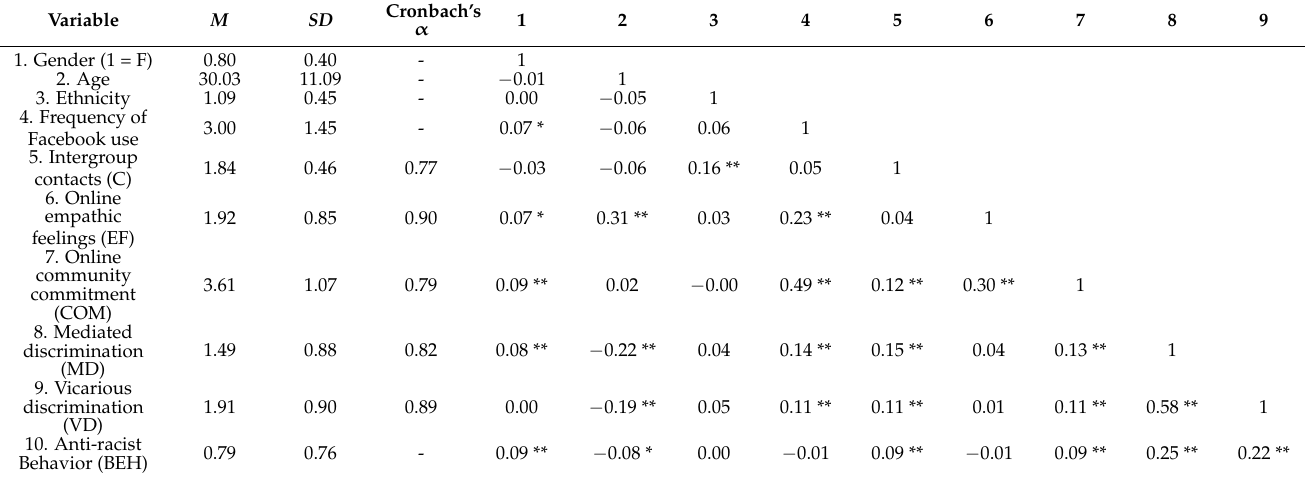
Table 2. Mean, standard deviation, Cronbach’s α and zero-order correlations of the considered measures ( n =